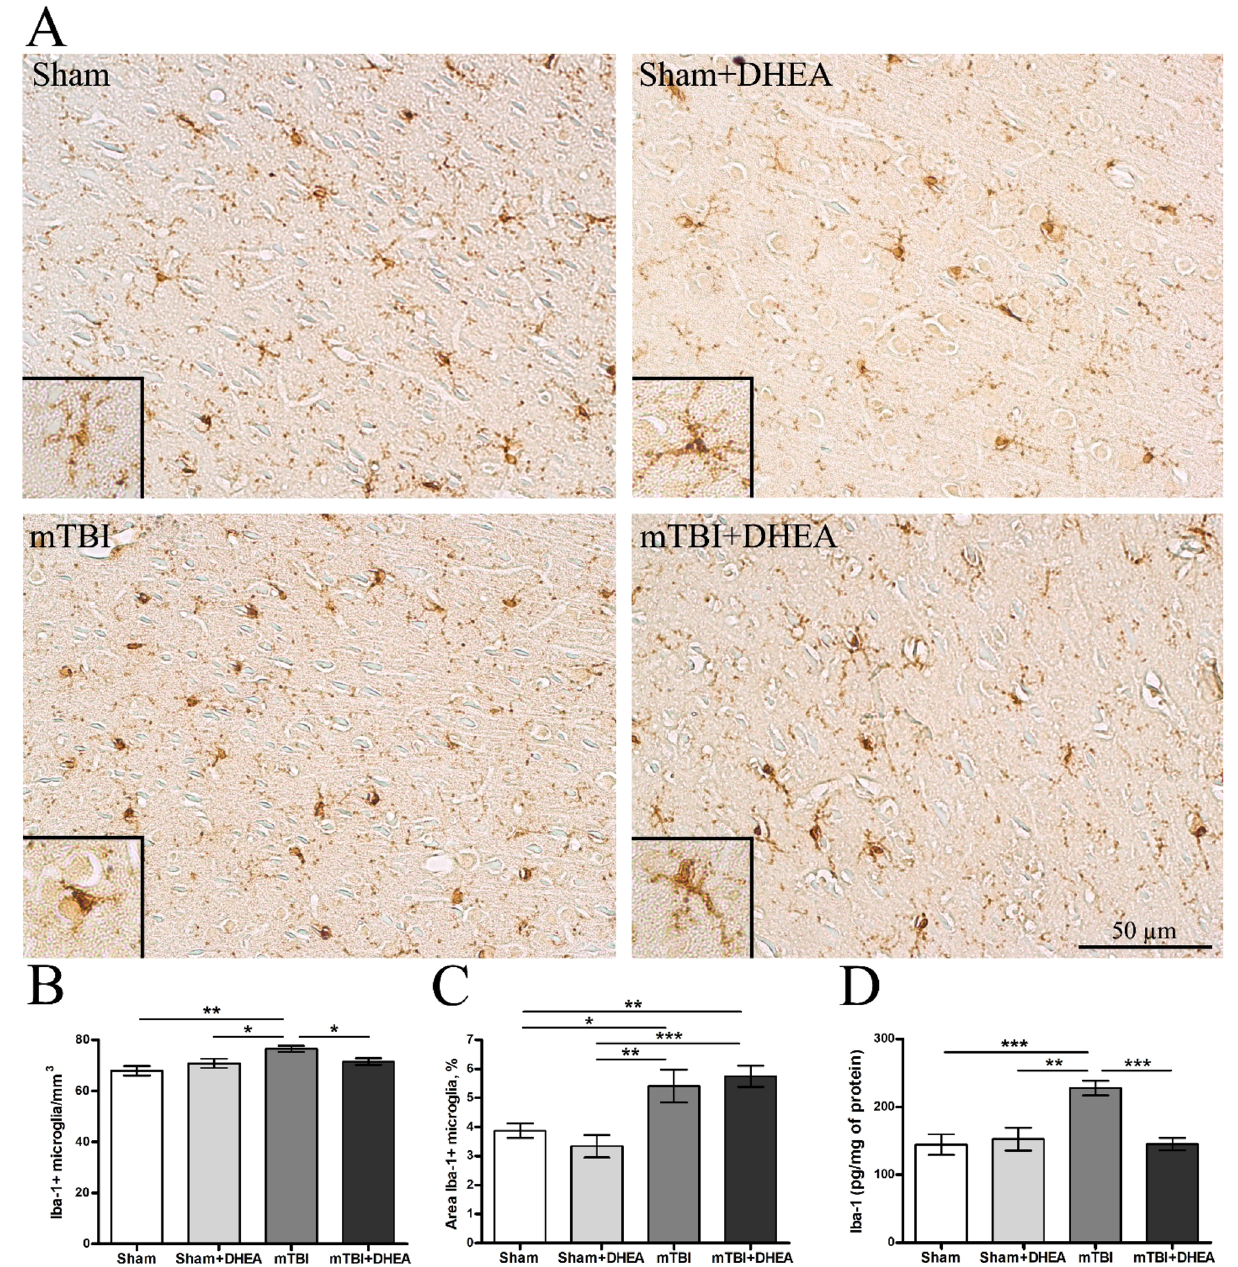
Figure 2. Expression of iba-1-positive microglia in the cerebral cortex in Sham, TBI and after DHEA treatment. ( A ) Representative images of Iba-1 immunohistochemically-stained slides. ( B ) The quantitative distribution of iba-1-positive microglia. ( C ) The staining area of the iba-1-positive microglia in the cerebral cortex. ( D ) The cerebral cortex iba-1 expression. Data are the mean ± SEM, n = 7/group, * P < 0.05, ** P < 0.01 and *** P < 0.001 (one-way ANOVA, post-test Tukey). Images were prepared with using GIMP 2.10.22 software (http://www.